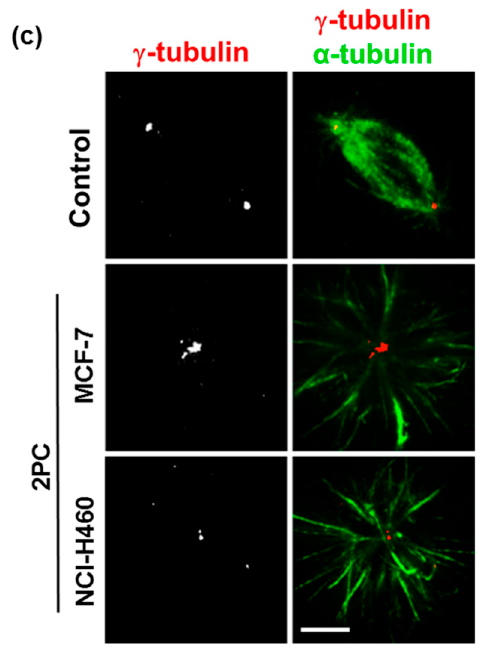
Figure 3. Treatment with PC2 induces mitotic spindle collapse in MCF-7 and NCI-H460 cells. ( a ) Immunofluorescence staining with anti- α -tubulin antibody. Control cells exhibited normal microtubule fibers (green) assembled into a well-organized bipolar mitotic spindle, while treated cells have monopolar spindles. DNA was counterstained with DAPI (blue); ( b ) Graph showing percentage of bipolar and monopolar spindles in control and compound-treated cells; ( c ) Double immunostaining with anti- γ -tubulin (red) and anti- α -tubulin (green) antibodies, showing typical face-to-face poles of a bipolar spindle in control and side-by-side poles of a collapsed spindle in compound-treated cells. Scale bar = 5 μ m.